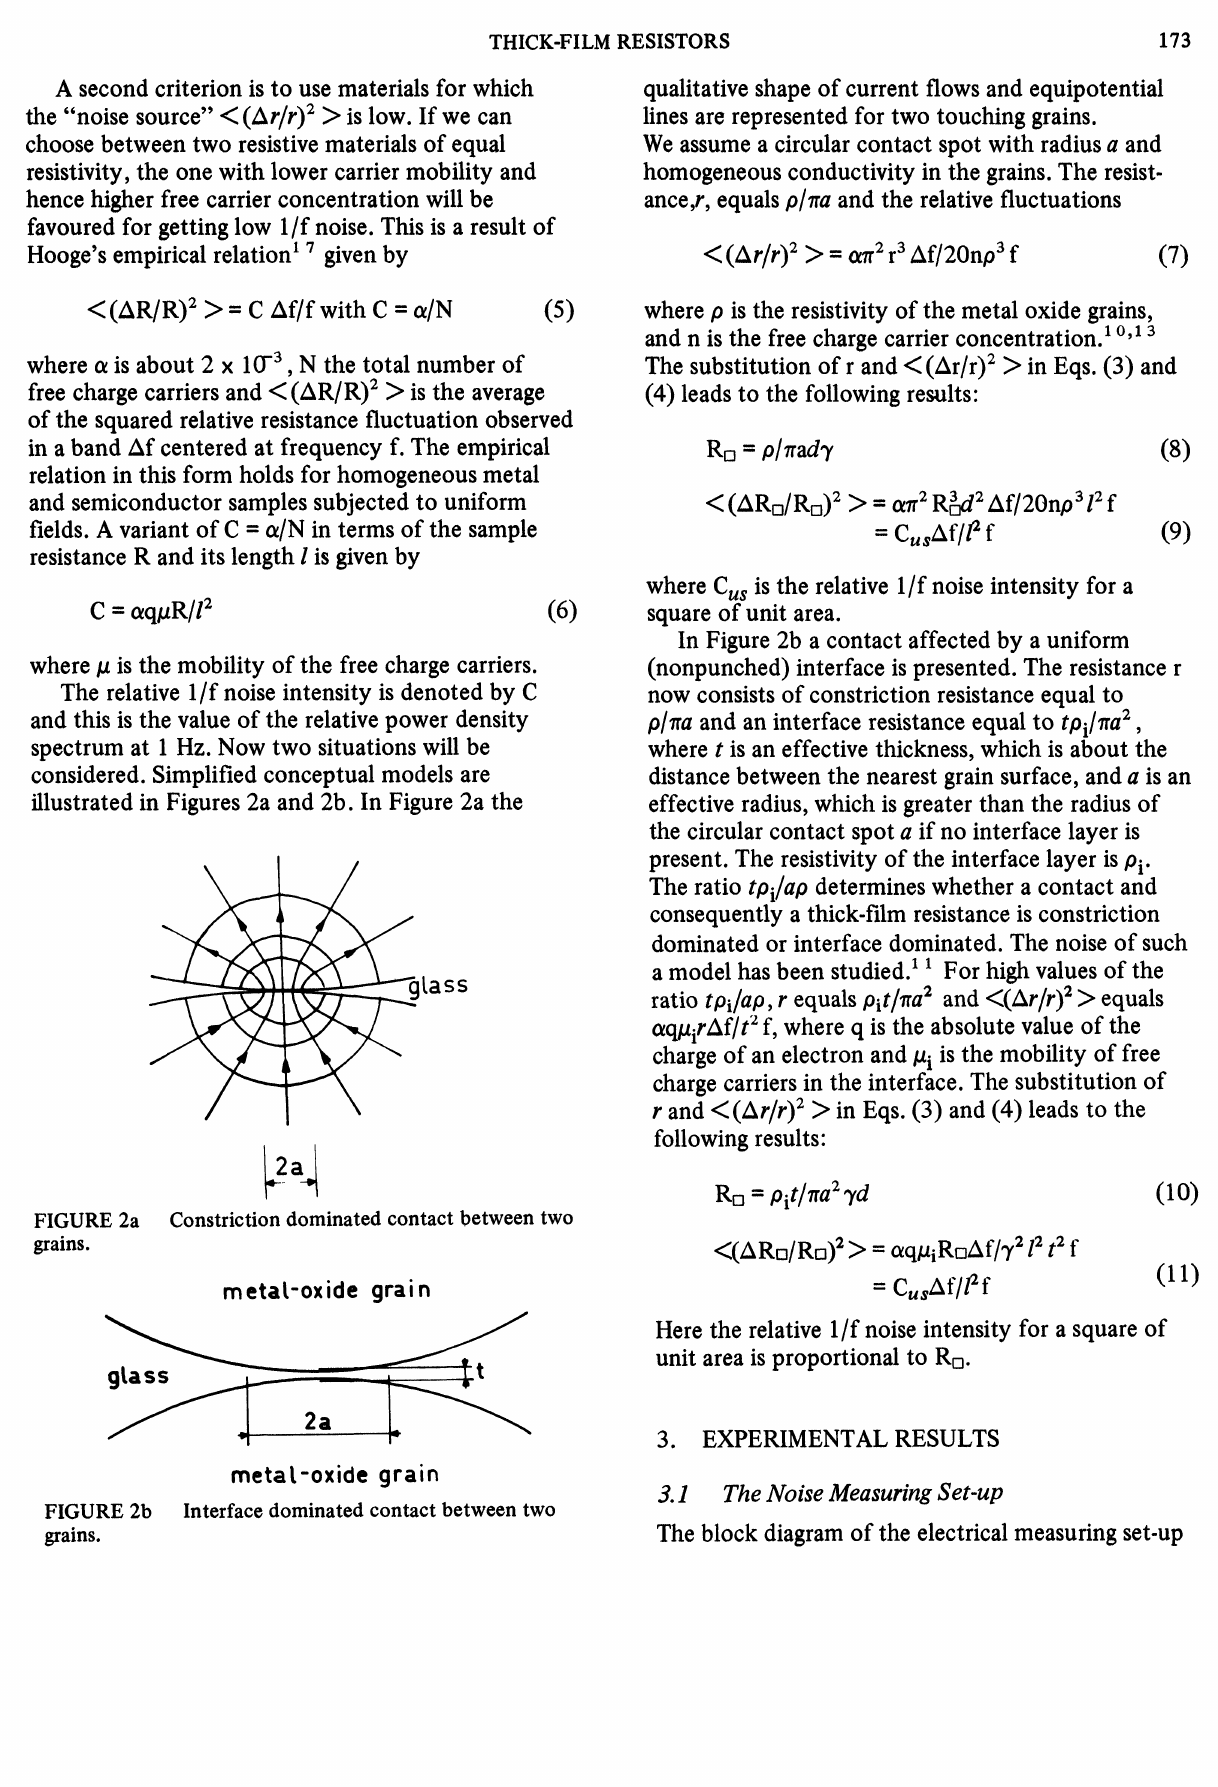
metat-oxide grain FIGURE 2b Interface dominated contact between grains.